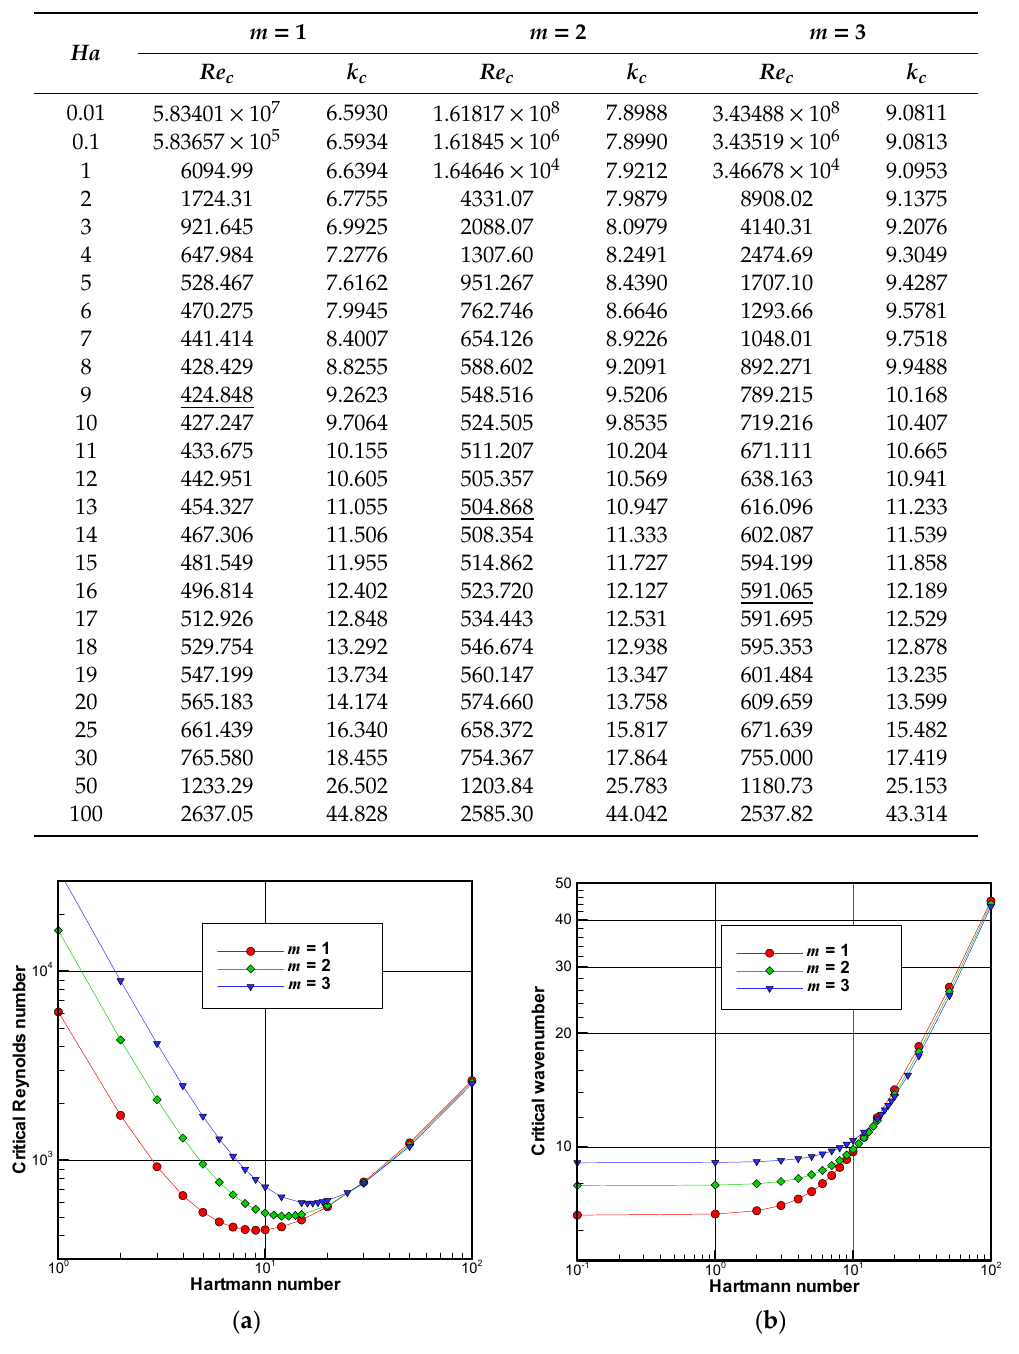
Table 1. Critical Reynolds number obtained for the various cases changing number of pole-pairs and the Hartmann numbers. The number of grids is 201.